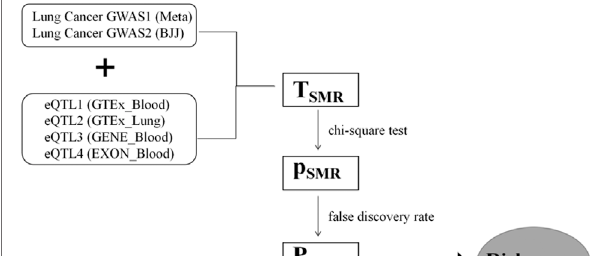
Frontiers in Cell and Developmental Biology |